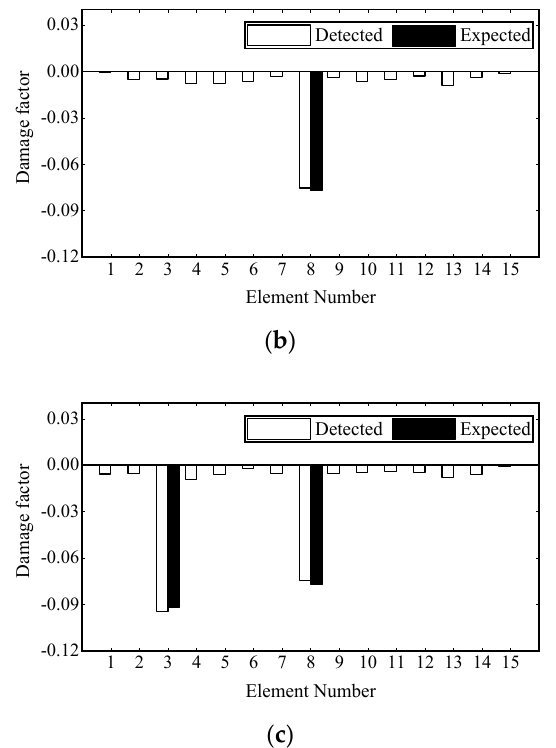
Figure 14. Damage identification results on experimental beams: ( a ) scenario 1; ( b ) scenario 2; ( c ) scenario 3.